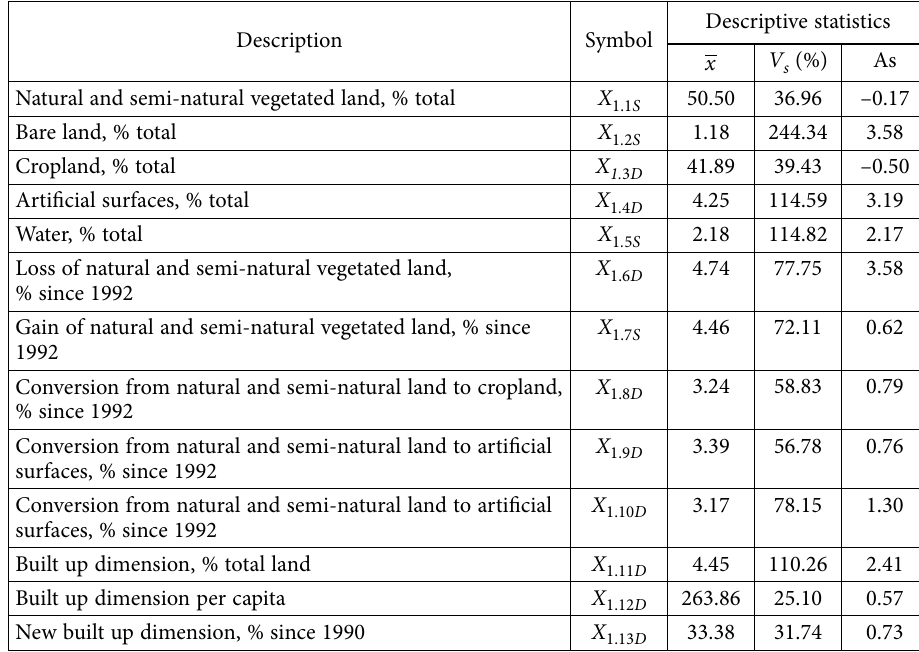
Table 2. Natural asset base (dimension